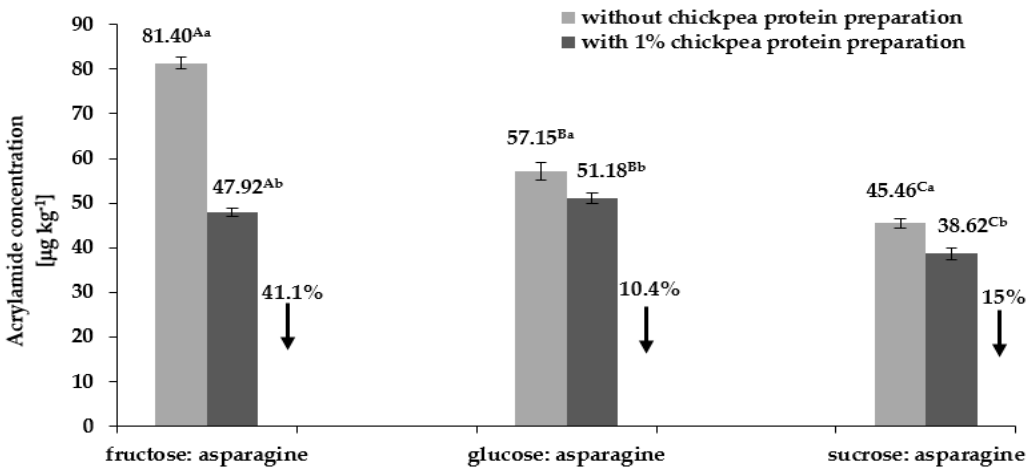
Figure 2. Changes in acrylamide concentration in carbohydrate–asparagine model systems with 1% chickpea protein preparation, subjected to thermal treatment, depending on carbohydrate type; uppercase letters—different letters indicate significant differences in acrylamide content between systems depending on carbohydrate type regardless of the addition of chickpea protein ( n = 3; p ≤ 0.05); lowercase letters—different letters indicate significant differences in acrylamide content in a given model system depending on the addition of chickpea protein preparation ( n = 3; p ≤ 0.05); data are presented as mean ± SD.